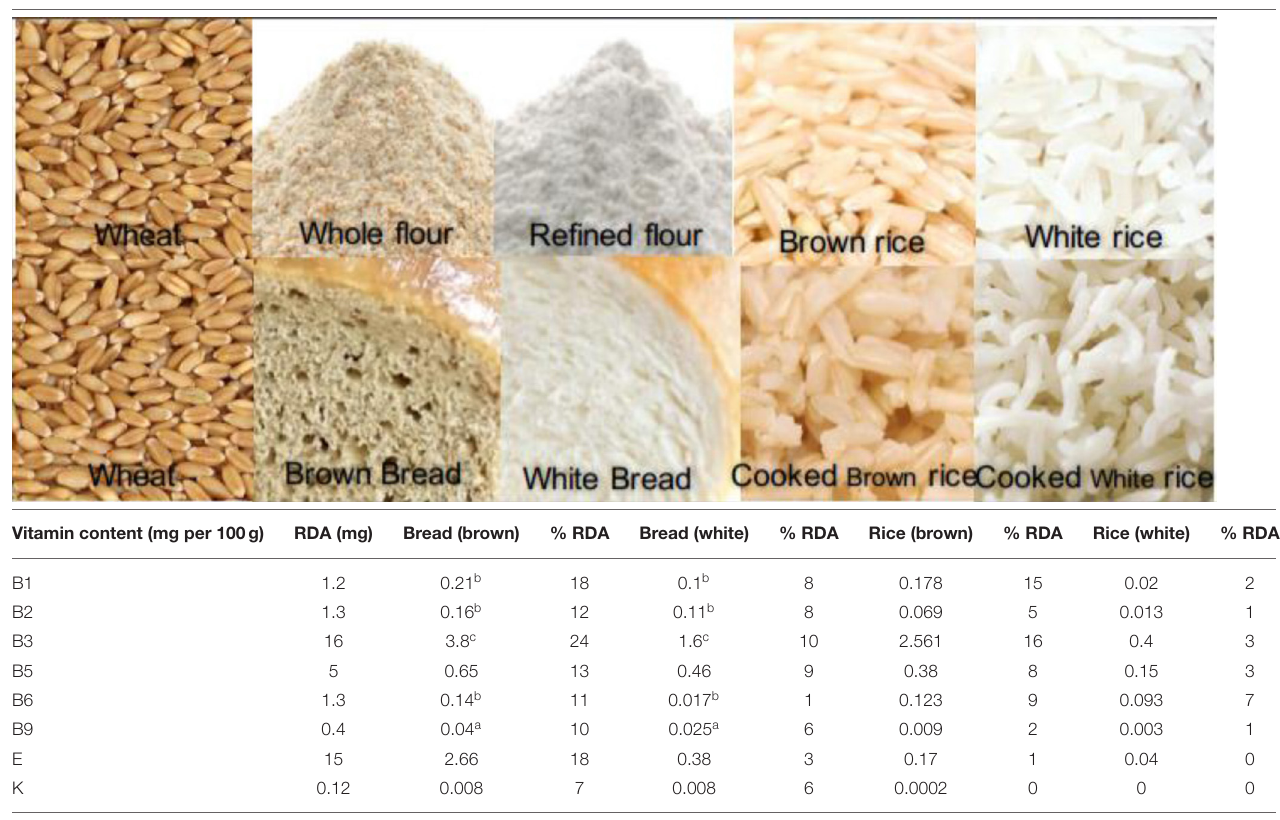
TABLE 2 | Vitamin content (mg/100 g) and % RDA of cooked whole and refined cereals.